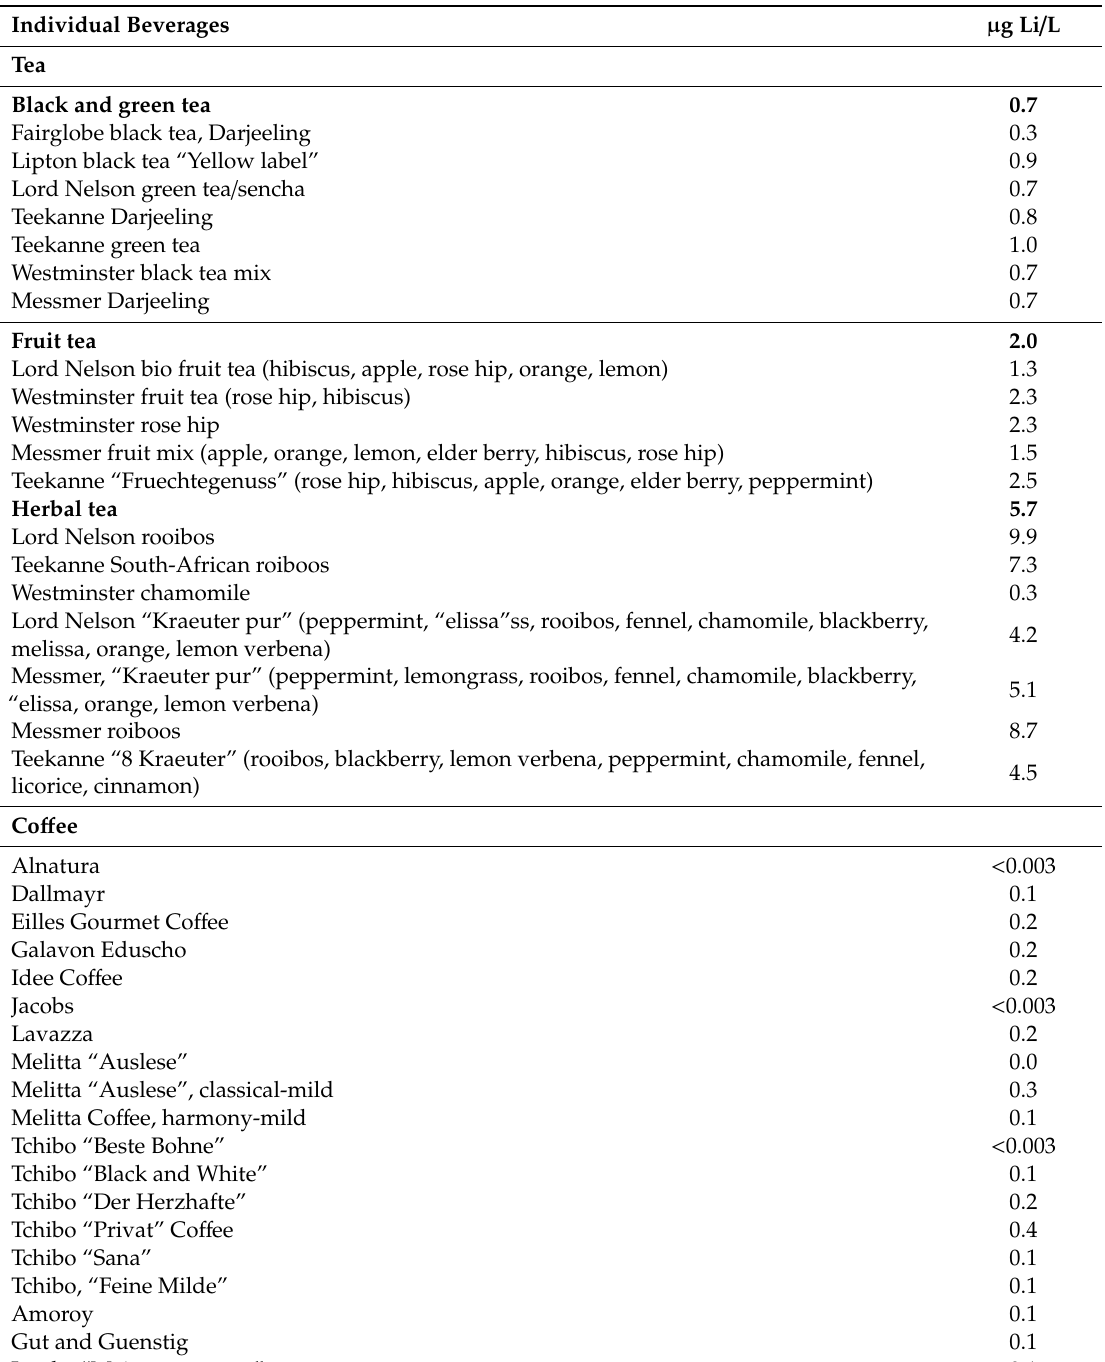
Table 6. Lithium concentrations ( µ g Li / L) of tea and co ff ee infusions. Tea samples were grouped in black and green, fruit and herbal tea. Li concentrations were measured by inductively coupled plasma mass spectrometry